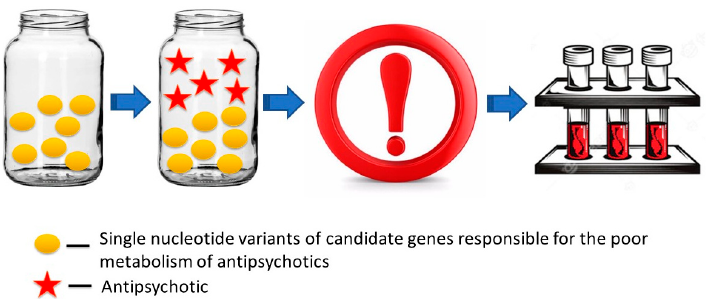
Figure 10. Poor metabolizer phenotype predisposing to high toxic blood levels of antipsychotics resulting in symptomatic QT interval prolongation. Antipsychotics that affect heart rate and conduction may be used, but with caution, and preferably in monotherapy, with dynamic therapeutic drug monitoring of the plasma antipsychotic levels.